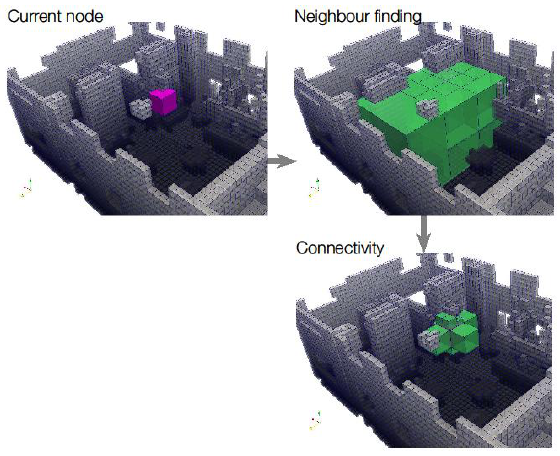
Figure 13: Connectivity generation